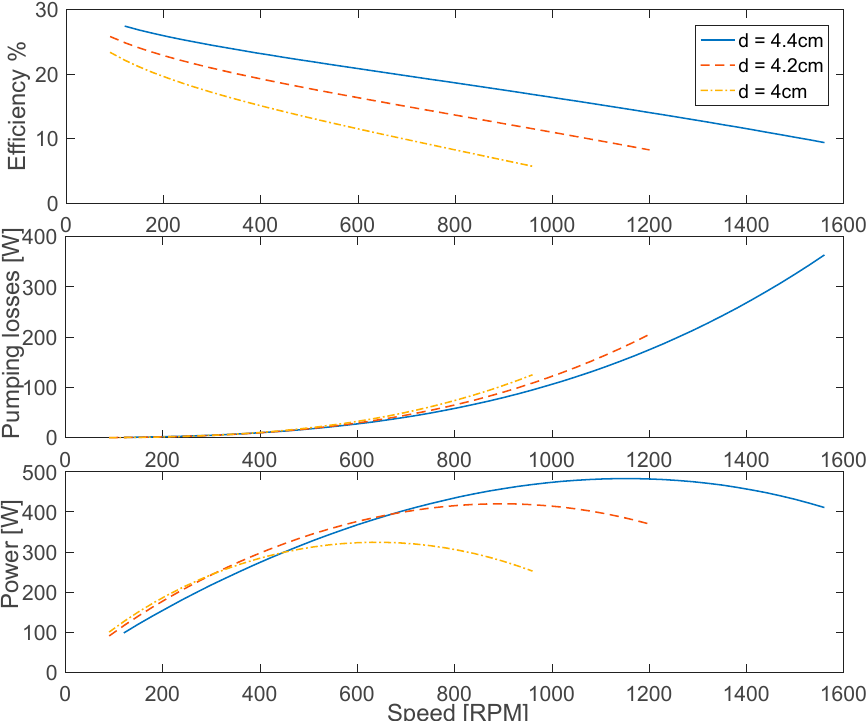
Figure 9. Influence of increasing the isothermal fins diameter on the Franchot engine performance for doubled Franchot engine cylinder length L e = L c = 100 cm.